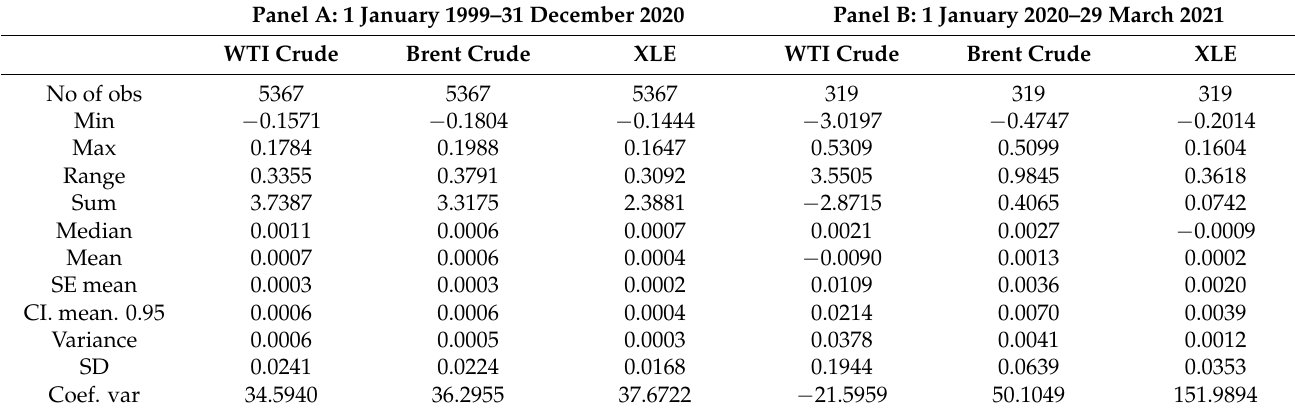
Table 1. Descriptive statistics for one-day returns for WTI, Brent, and